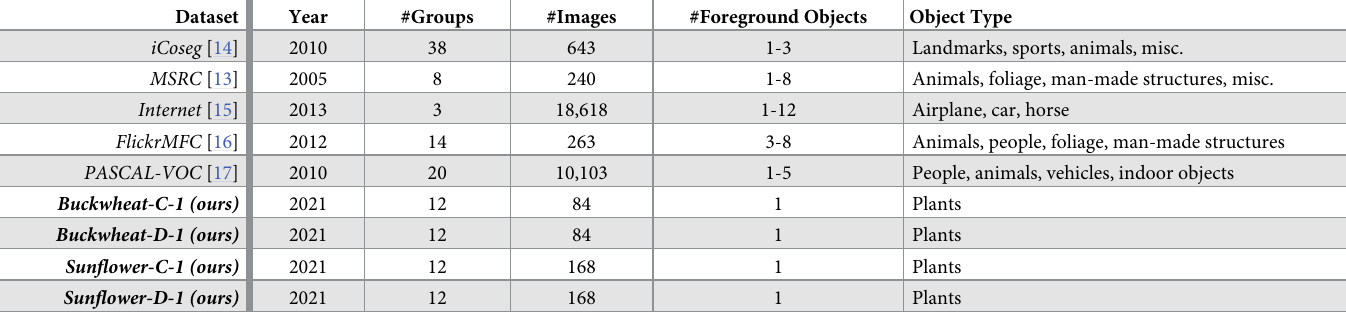
Table 1. Characteristics of existing cosegmentation datasets with our four proposed datasets. For our analysis, we will use iCoseg, MSRC, and Internet.